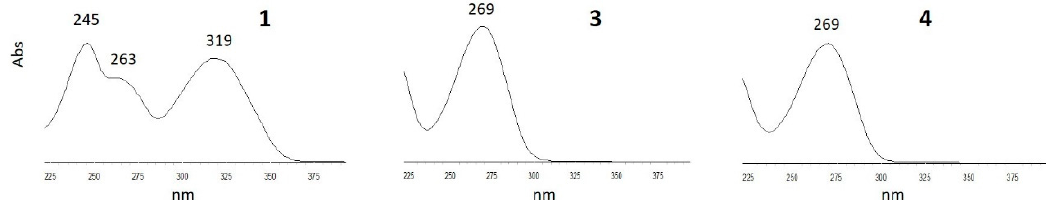
Figure 5. HPLC trace (detection 260 nm) of irradiation of a solution of isolated 1 in water during 30 min showing the two products 3 and 4 at Rt = 27 min and 29 min, respectively.